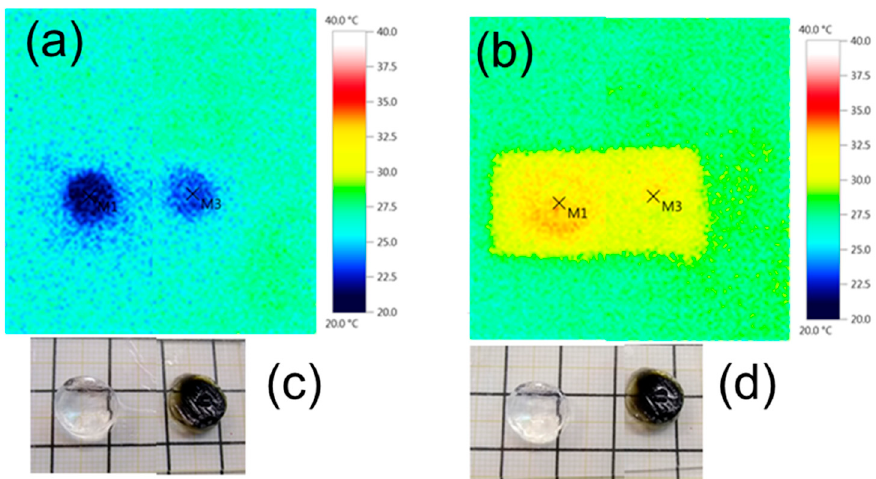
Figure 5. Comparative images of the hydrogel (transparent, left) and reduced (non-conductive) electromagnetic radiation thermomechanochemical (ER-T-MCh) nanocomposite (brown, right) made by in situ polymerization of aniline loaded inside a cPNIPAM hydrogel (IPH). Before measurement, both samples were treated with a reductant (phenylhydrazine). The thermographic images are shown in the upper panels ( a , b ). The scales at the left of each panel link color with temperatures. The optical photographs are shown in the lower panels ( c , d ). The images in ( a , c ) show the samples before irradiation, while the images in ( b , d ) depict the materials after microwave irradiation (2.4 GHz, 70 W, 10 s).